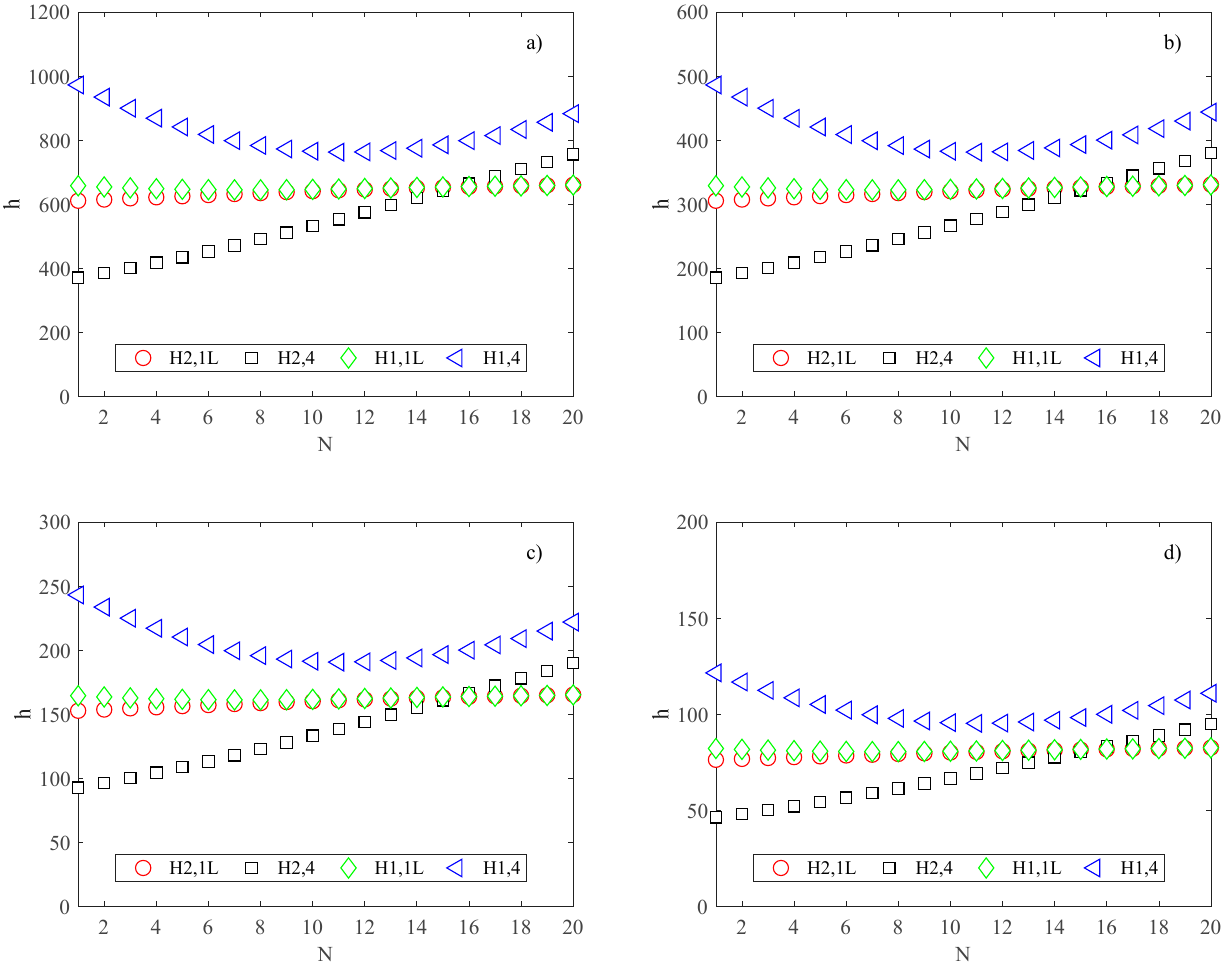
Figure 8. Heat transfer coefficient (W/m 2 K) for different channel numbers and conditions; ( a ) B = L = 2.5 mm; ( b ) B = L = 5 mm; ( c ) B = L = 10 mm; ( d ) B = L = 20 mm. The substrate temperatures θ s evaluated by means of Equation (19) as a function of the channel number N are presented in Figure 9 for the different heat sink sizes.